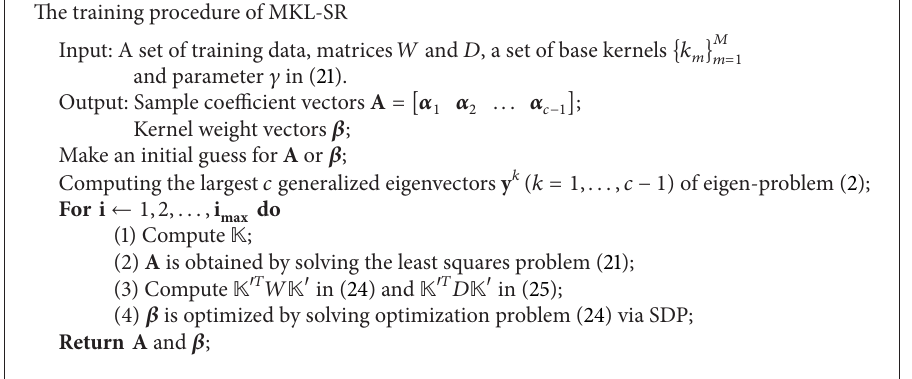
Algorithm 1: MKL-SR